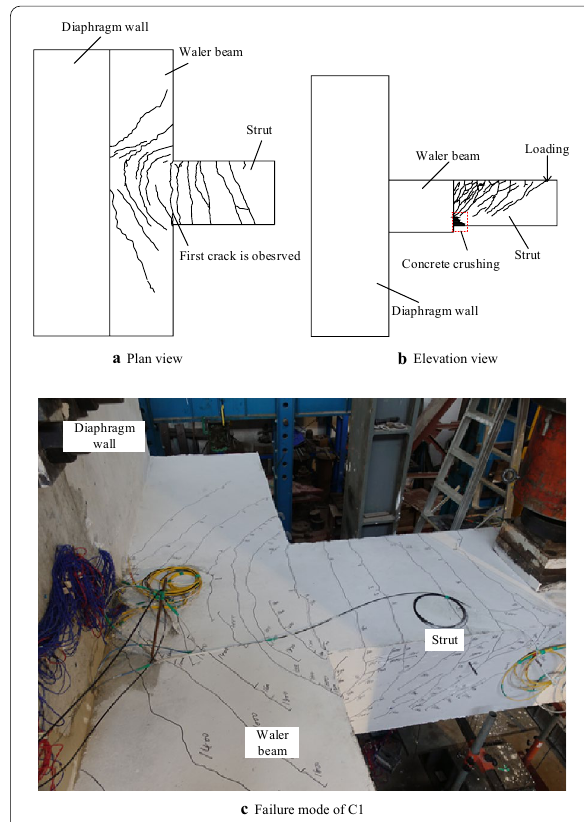
Fig. 12 Crack distribution at failure of